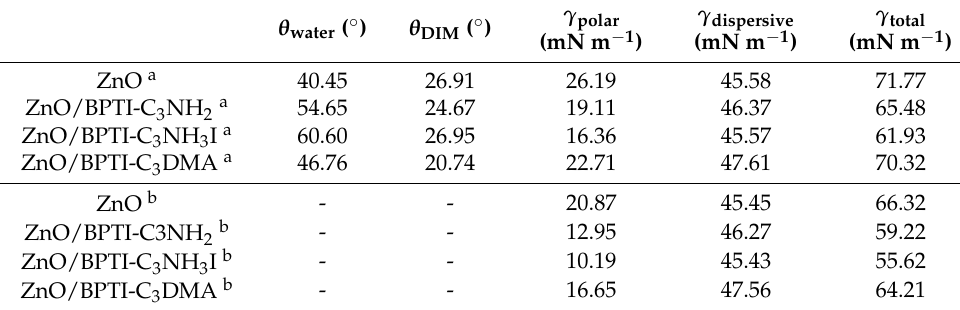
Table 1. Contact angles and surface energies of the